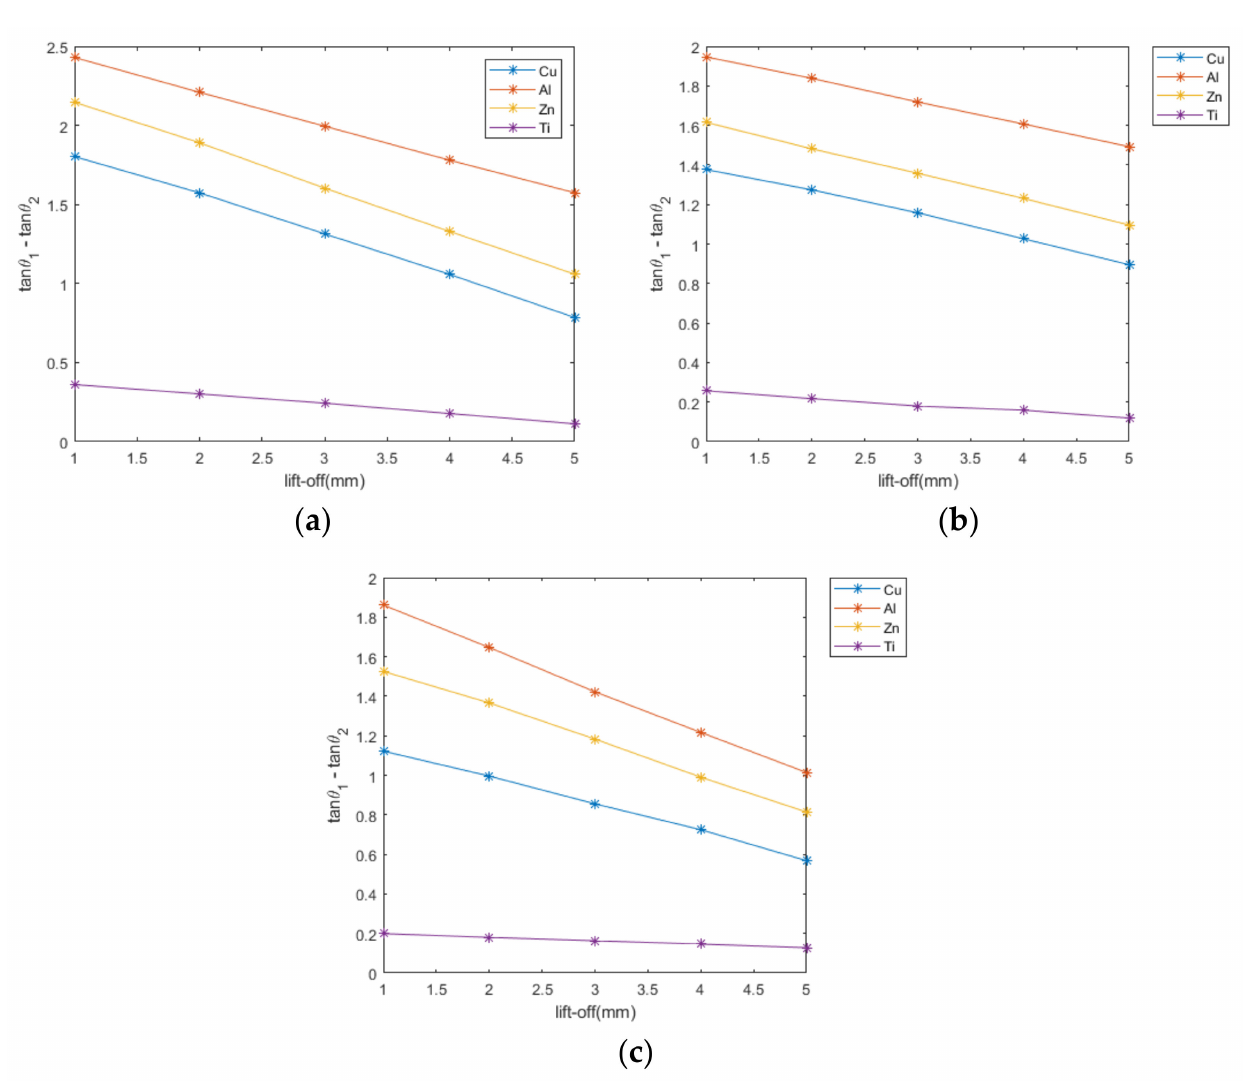
Figure 7. Linear relationship between the feature and lift-off of different metals under different shapes. ( a ) plane ( b ) cylinder ( c )